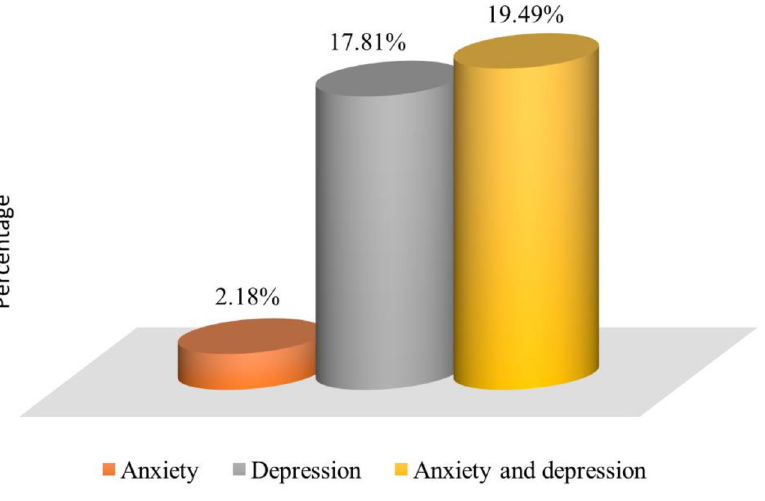
Fig 2. Presence of psychosocial health problems.